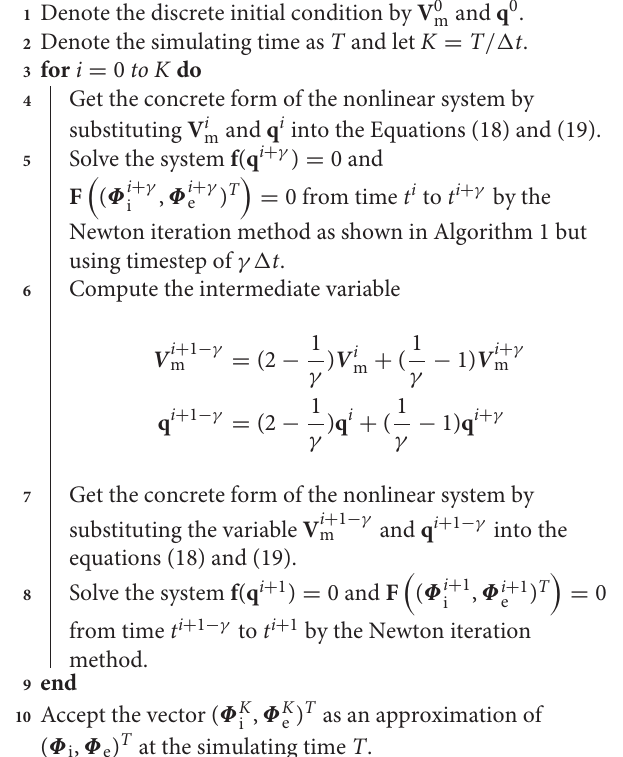
Algorithm 2: the CBDF2